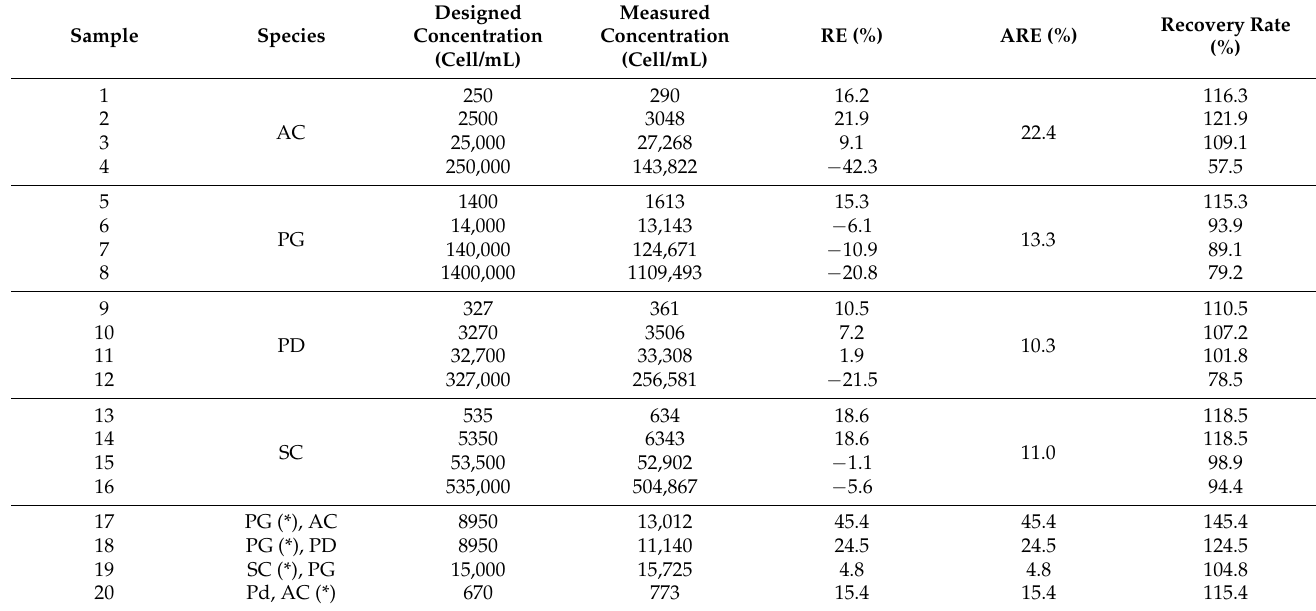
Table 7. Comparison of results for pure samples and mixed